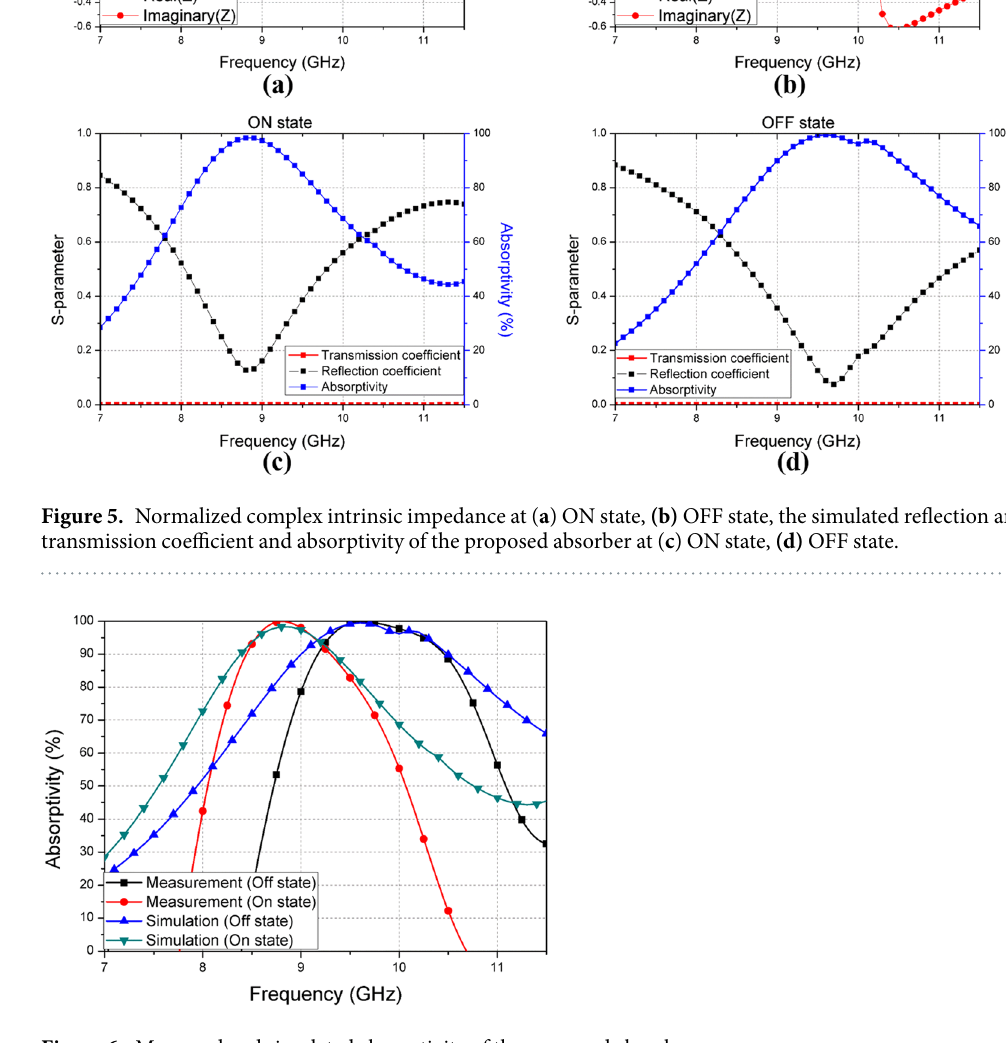
Figure 6. Measured and simulated absorptivity of the proposed